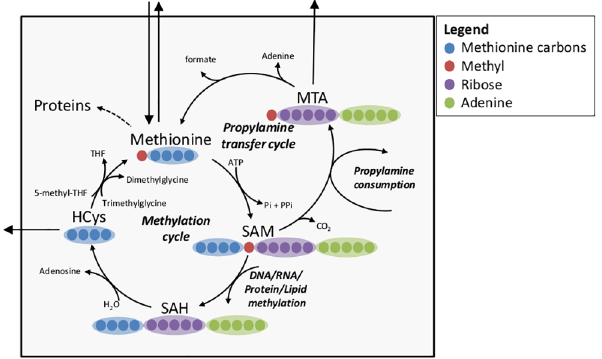
Fig 5. Methionine metabolism, including transmethylation cycle, polyamine biosynthesis and methionine salvage cycle. Metabolites abbreviations: SAM: S-Adenosylmethionine; SAH: S-Adenosylhomocysteine; HCyc: L-Homocysteine; MTA: Methylthioadenosine.